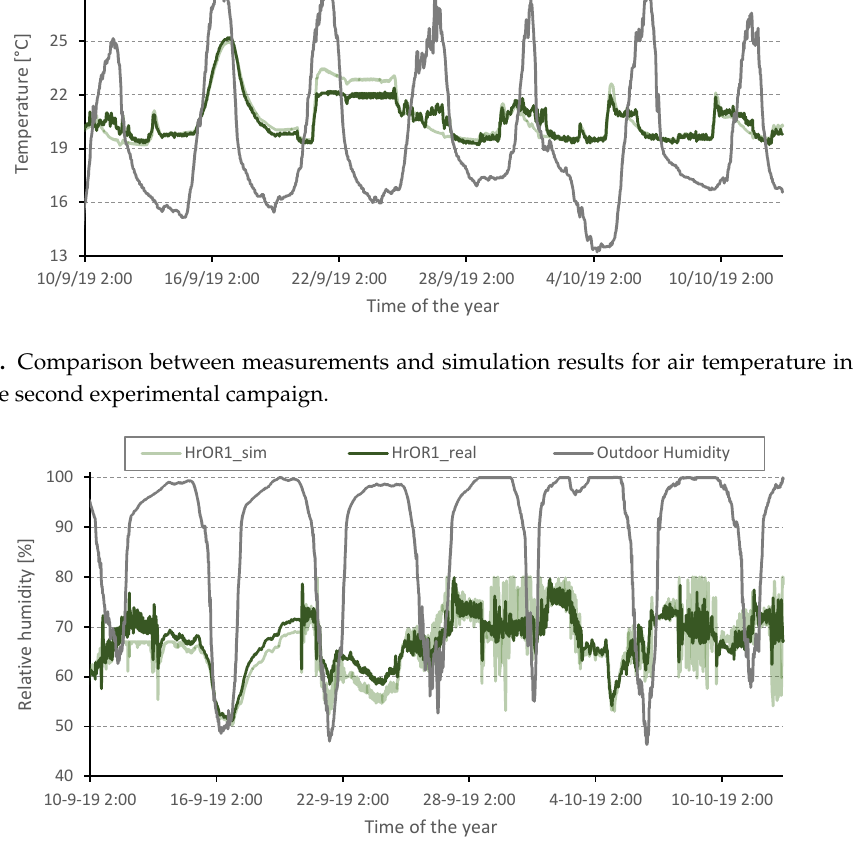
Figure 12. Comparison between measurements and simulation results for air RH in OR1 during the second experimental campaign.